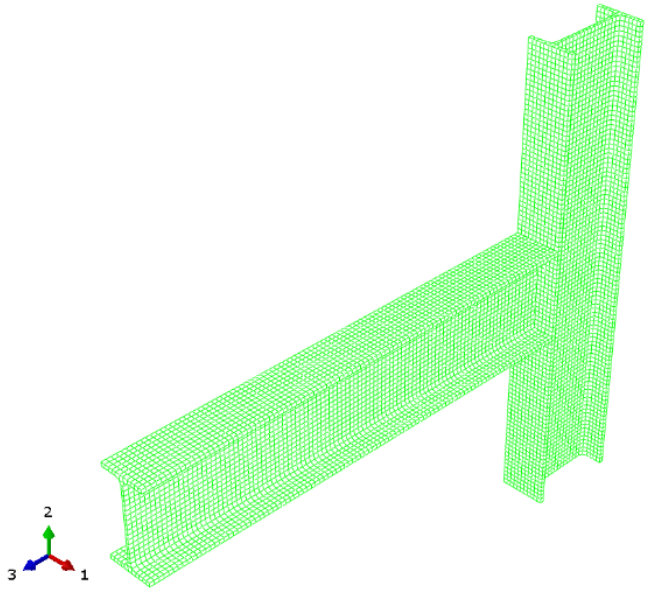
Figure 11. Finite element model of a non-strengthened connection consisting of IPE 200.